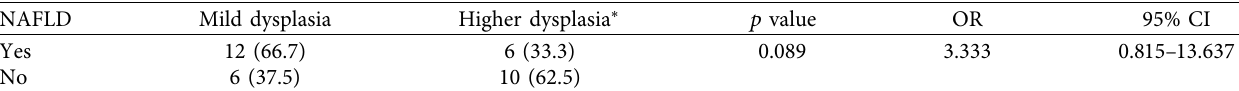
Table 6: Association between NAFLD and degree of adenoma dysplasia ( n �